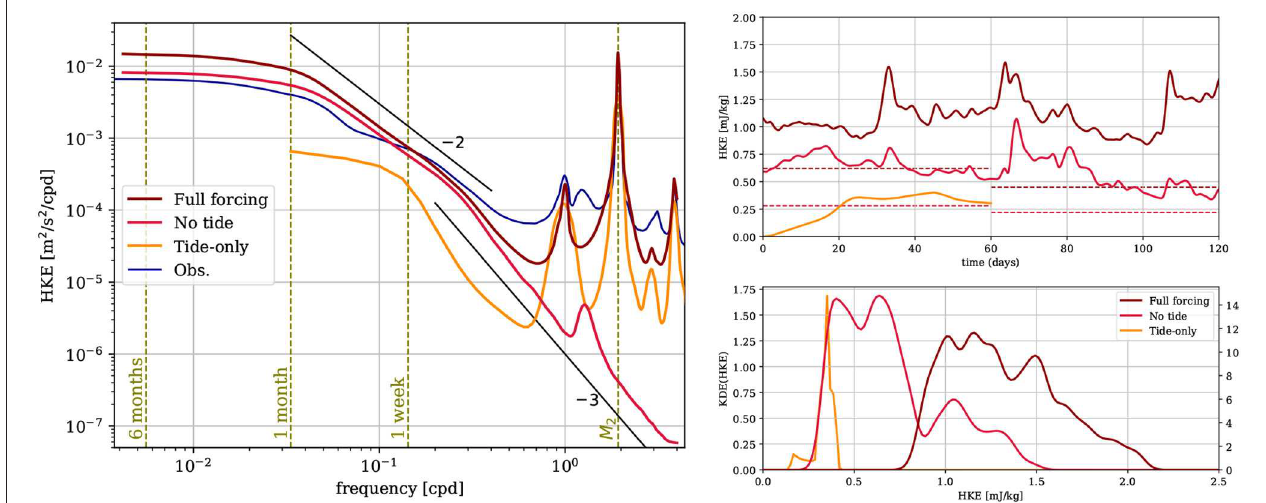
FIGURE 10 | Left panel: Horizontal Kinetic Energy spectra at 2,000 m, spatially averaged in the rift valley above 35.7 ◦ N for the different numerical runs. For the tide-only simulation, the spectra are computed over 1 month between day 25 and 55. The spectrum in blue is taken from averaging data from different current meters between 1,800 and 2,100 m on the moorings at Rainbow and Lucky-Strike. Note that energetic eddies present in the basins cannot be measured by these moorings because of their position, which probably explains smaller energy density at low frequencies ( < 1 day − 1 ). Right panel, top: Evolution of the Horizontal Kinetic Energy of the low-pass filtered velocity (cutoff frequency 1 / 48 h − 1 ) over four months (only 2 months are available for the tide-only run), spatially averaged in the rift valley. Dashed lines indicate HKE of 2-month averaged velocities. Right panel, bottom: KDE of the distribution of the low-frequency HKE shown above, computed over the same period as the spectra in the left